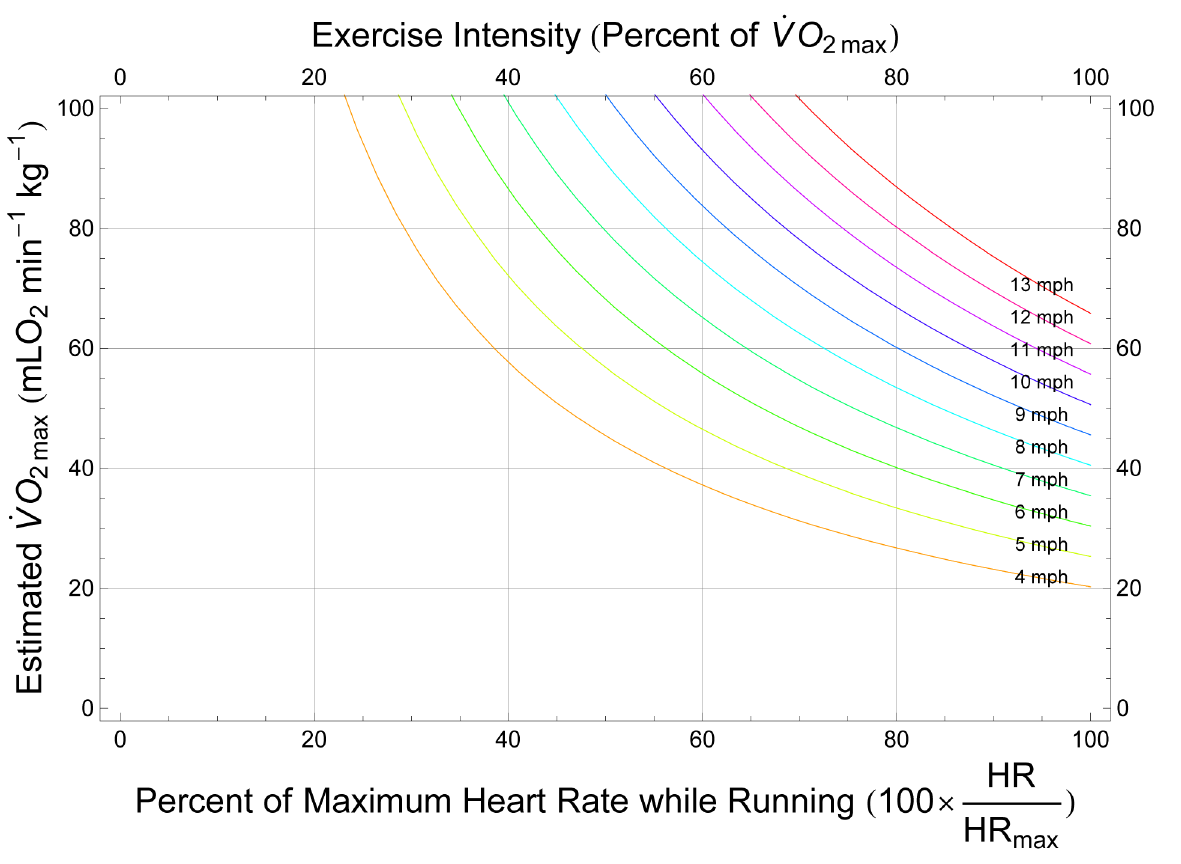
Figure 4. Estimating the aerobic capacity of a typical runner. Computed approximations of _ VVO 2 max (in terms of milliliters of oxygen per minute per kilogram body mass), as a function of estimated fraction of maximum heart rate while running at a given speed, are shown as a set of colored curves. Each line corresponds to a particular running speed (Orange, 4 mph ( 6 : 4kmh { 1 ); Light Green, 5 mph ( 8 : 1kmh { 1 ); Green, 6 mph ( 9 : 7kmh { 1 ); Dark Green, 7 mph ( 11 : 3kmh { 1 ); Light Blue, 8 mph ( 12 : 9kmh { 1 ); Blue, 9 mph ( 14 : 5kmh { 1 ); Dark Blue, 10 mph ( 16 : 1kmh { 1 ); Purple, 11 mph ( 17 : 7kmh { 1 ); Magenta, 12 mph ( 19 : 3kmh { 1 ); Red, 13 mph ( 20 : 9kmh { 1 )). See the text for a detailed explanation.